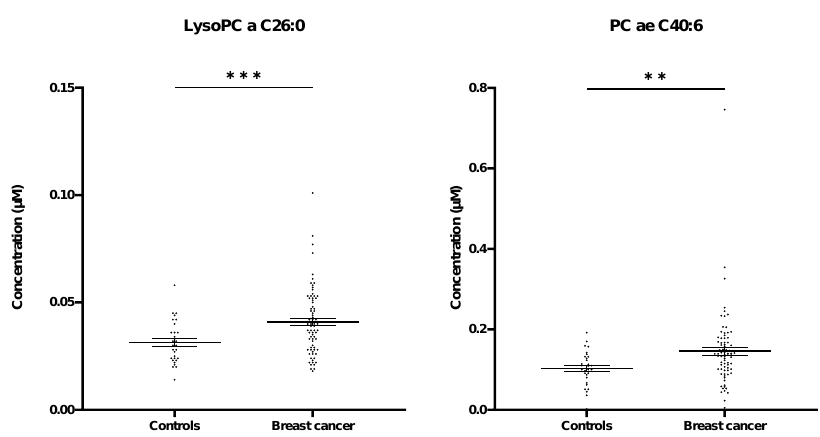
Figure A3. Very-long-chain LysoPC a 26:0 and ether-lipid PC ae 40:6 are elevated in breast cancer patient microvesicles. Concentration of lipids in microvesicles were determined with a p180-kit and displayed using the mean ± SEM. Groups were compared using two-tailed Student’s t-test with the Welsch correction for unequal standard deviations used. **: p < 0.01; ***: p < 0.001.